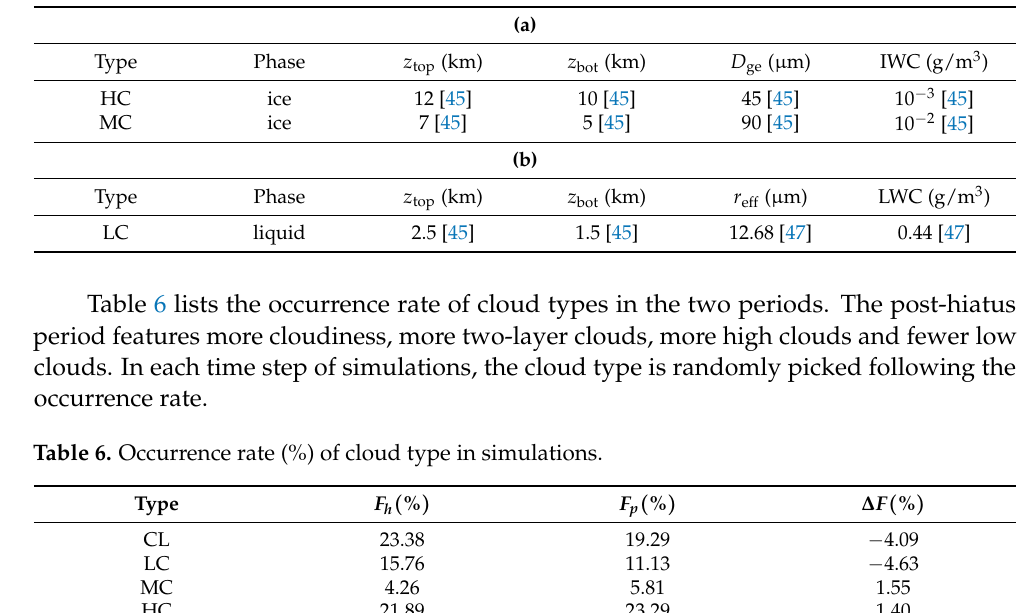
Table 5. Parameters of cloud types in simulations.